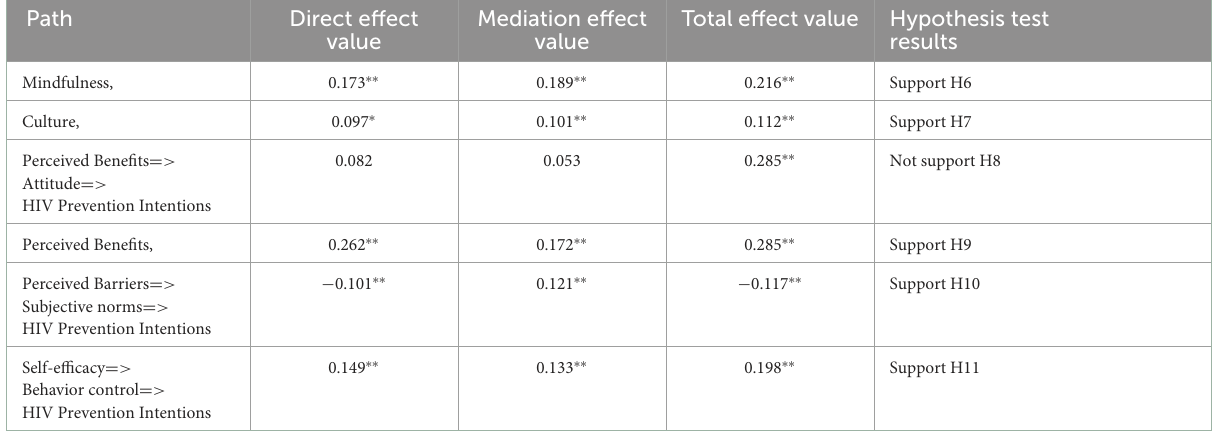
TABLE 5 Standardized Bootstrap mediation test